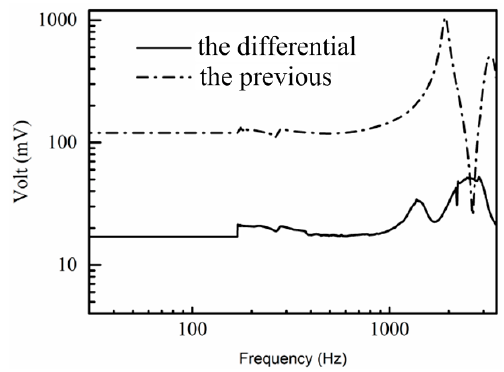
Figure 21. Output curves of the differential and the previous vector hydrophones.